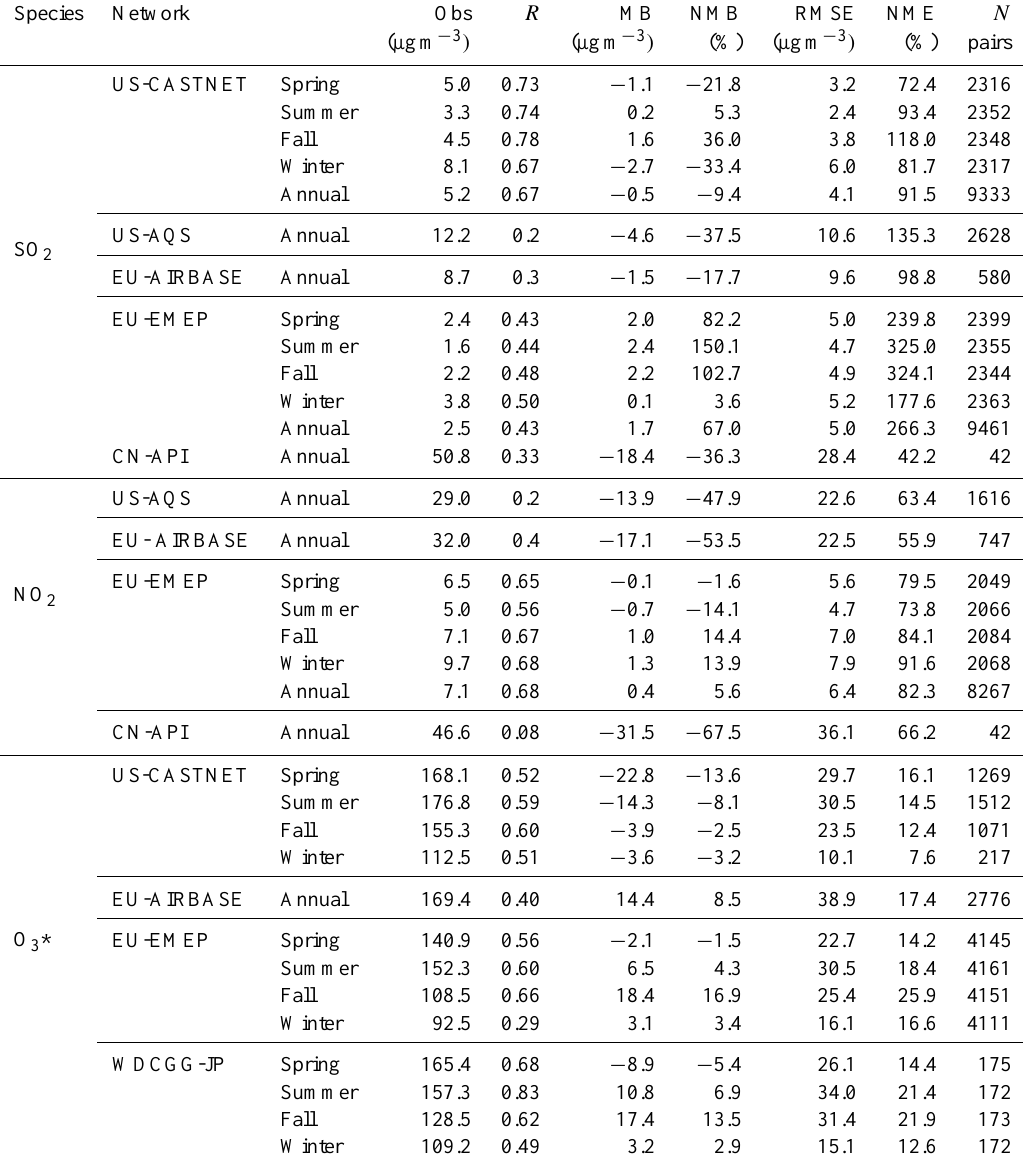
Table 2a. Model performance. Gaseous species. Species Network US-CASTNET